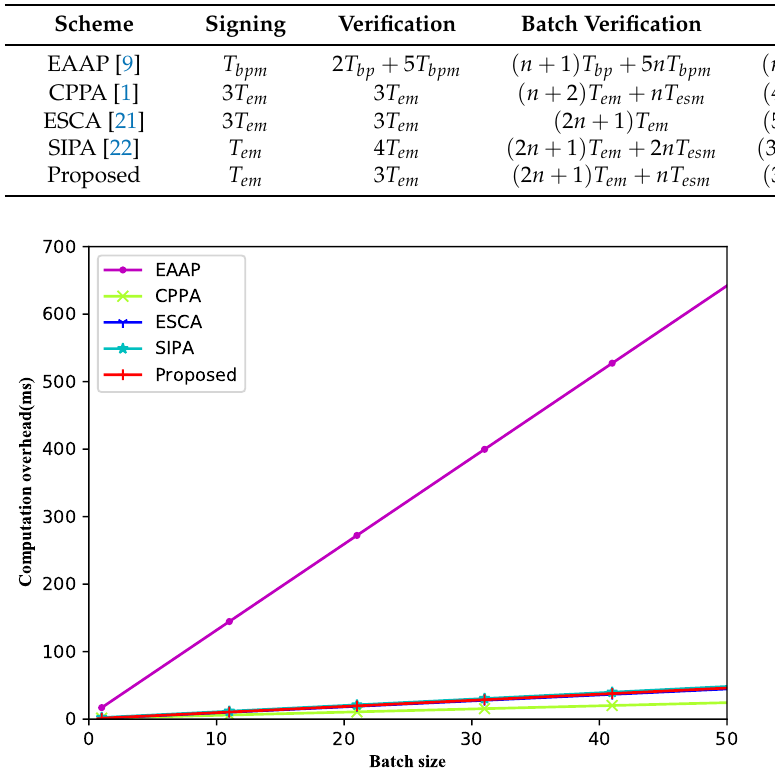
Figure 2. Comparison of computation overheads for different batch sizes.